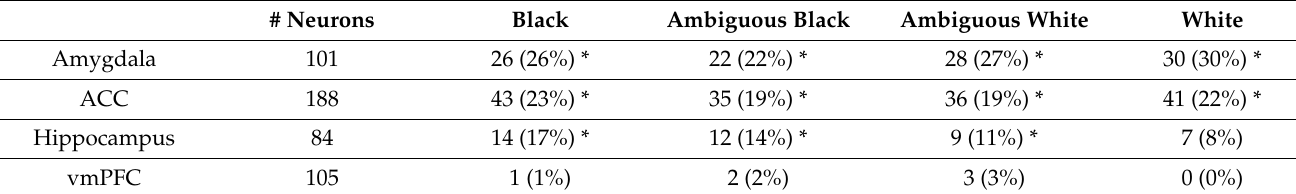
Table A2. Percentages of neurons significant for race category (relative to background firing) for each brain area, excluding all recordings from identified seizure onset zones. Values with asterisks denote significant proportions in binomial tests ( p < 0.05), after correction for multiple comparisons. # Neurons Black Ambiguous Black Ambiguous White